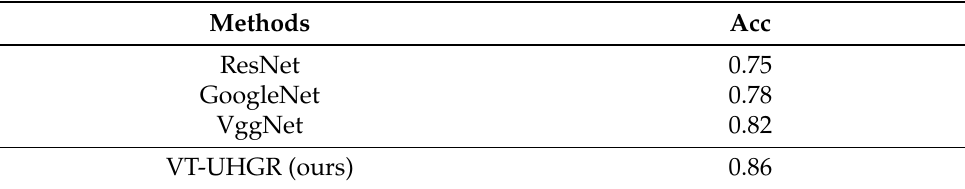
Table 2. Quantitative comparison of end-to-end methods on the SCUBANet dataset.